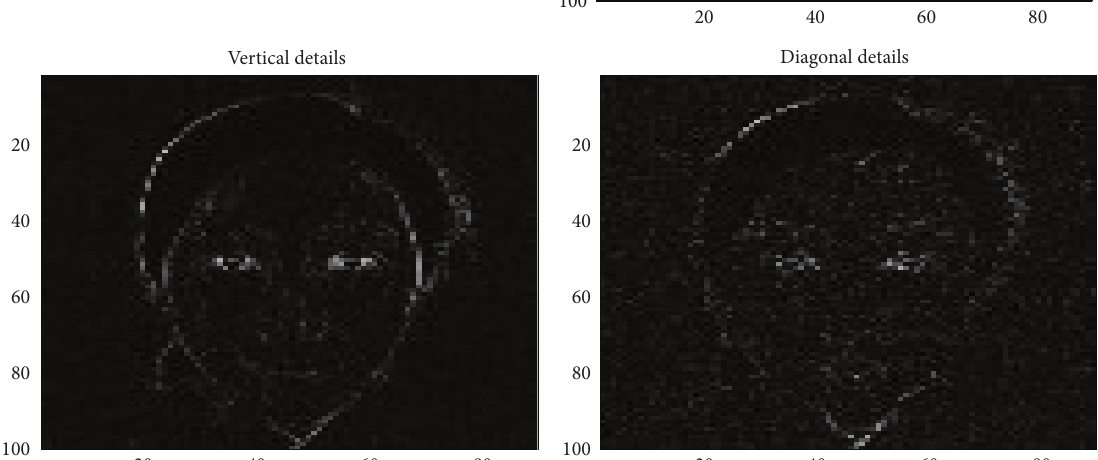
Figure 3: DWT decomposition of face image